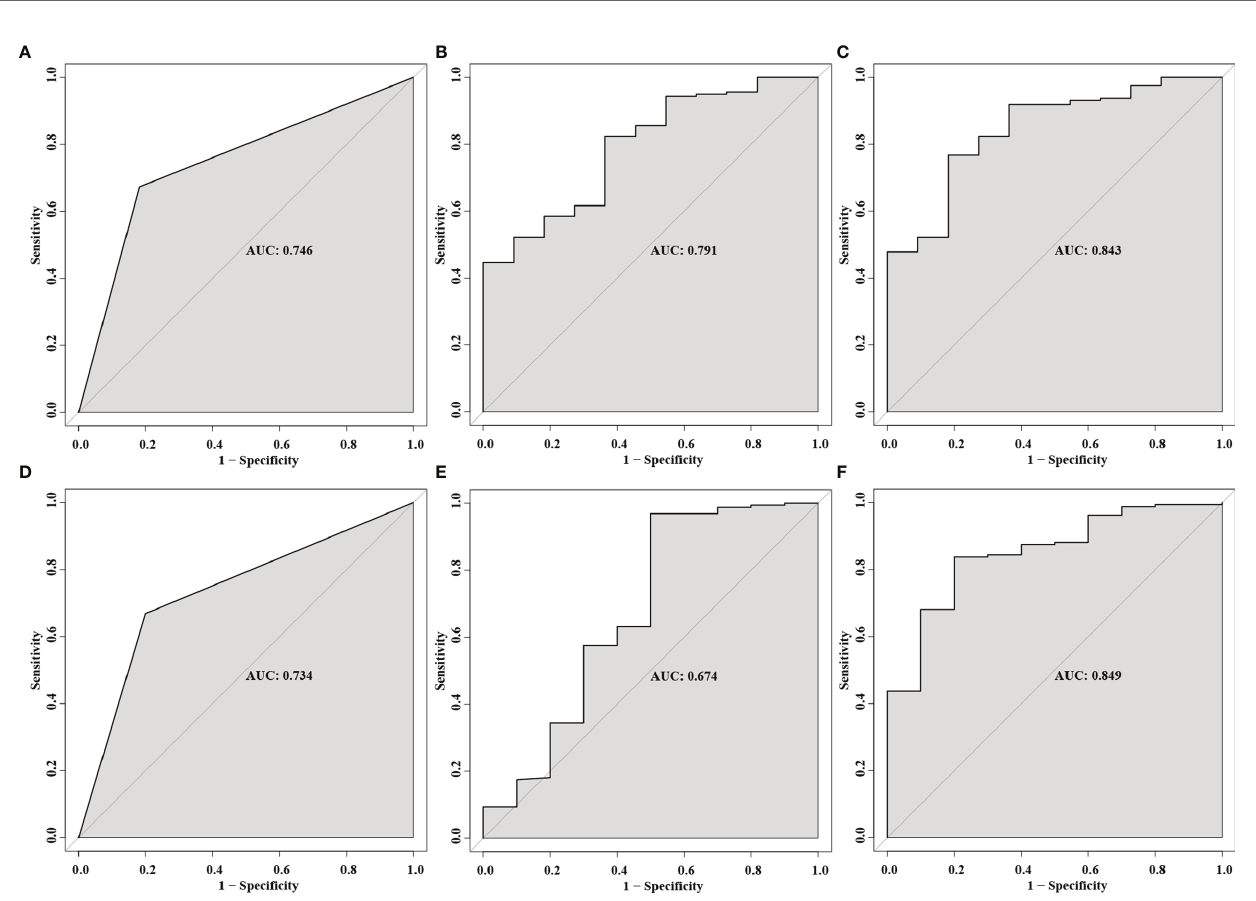
FIGURE 6 | Receiver operating characteristic (ROC) curves for the predictor of multivariable prediction models developed for postoperative VA: tight adhesion (A) , increased temporal cpRNFL (B) , and the combination of all predictors (C) . ROC curves for the predictor of multivariable prediction models developed for postoperative VF: tight adhesion (D) , increased inferior cpRNFL (E) , and the combination of all predictors (F)